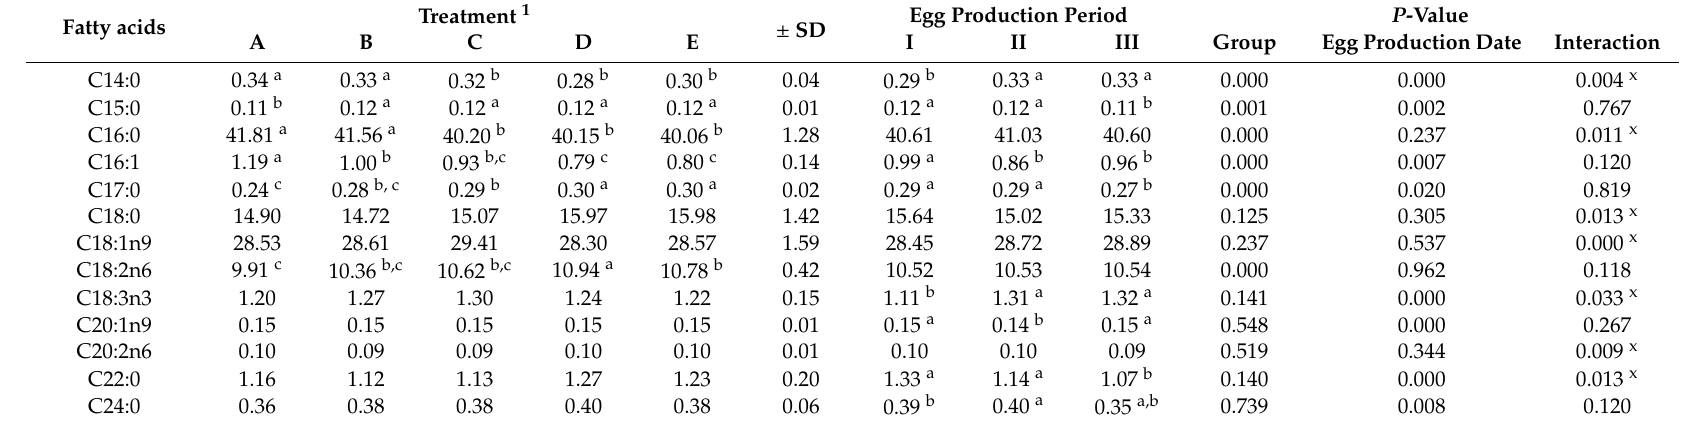
Table 8. Content of fatty acids (%) in egg yolk lipids (means ± SD